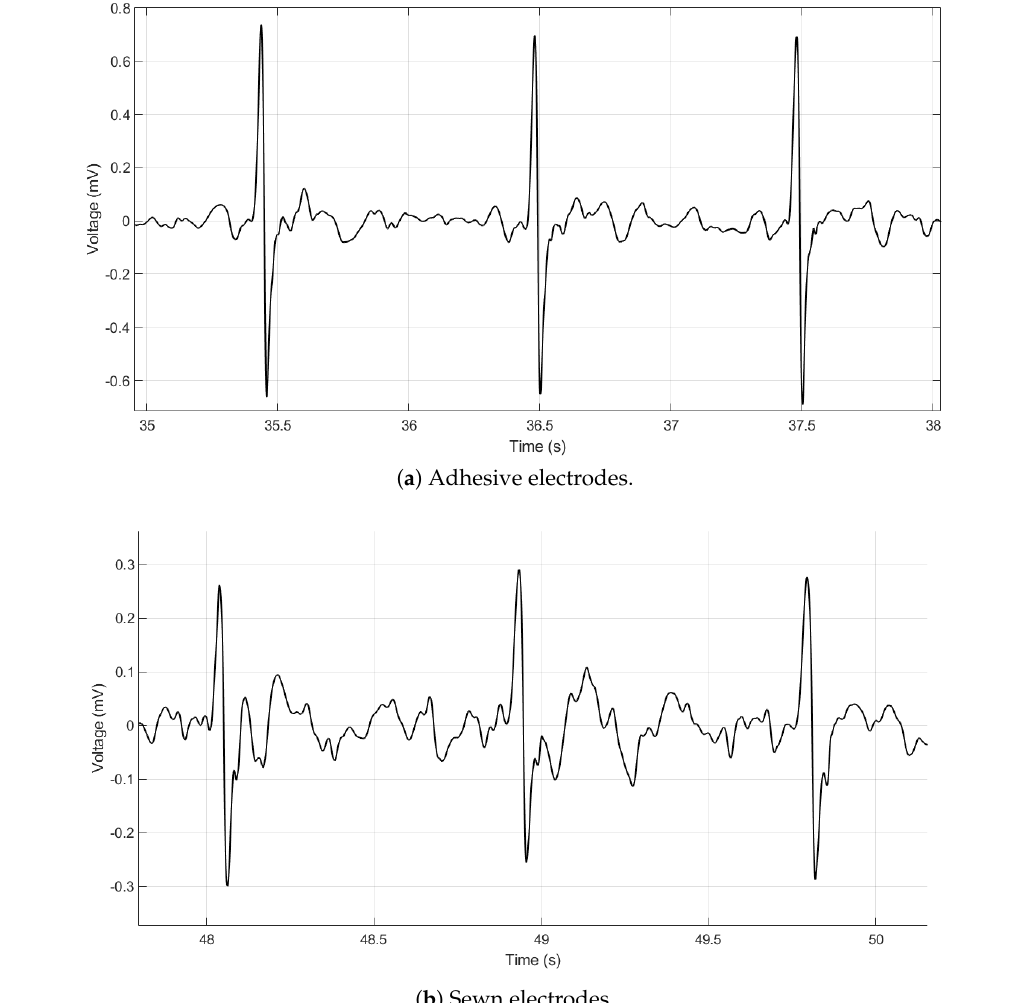
Figure 3. ECG data taken on a seated subject with adhesive electrodes ( a ) and sewn electrodes ( b ). Both signals are filtered with a 60 Hz notch filter and a Daubechies wavelet